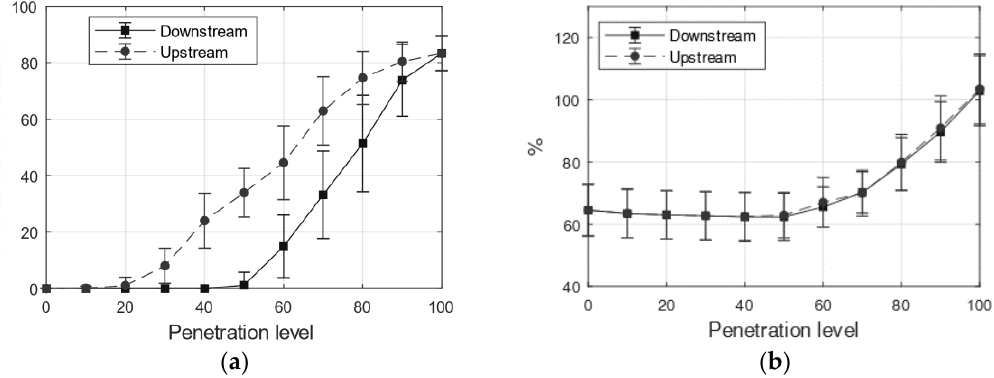
Figure 4. Feeder 4 results: ( a ) consumers with voltage issues and ( b ) feeder utilization capacity.